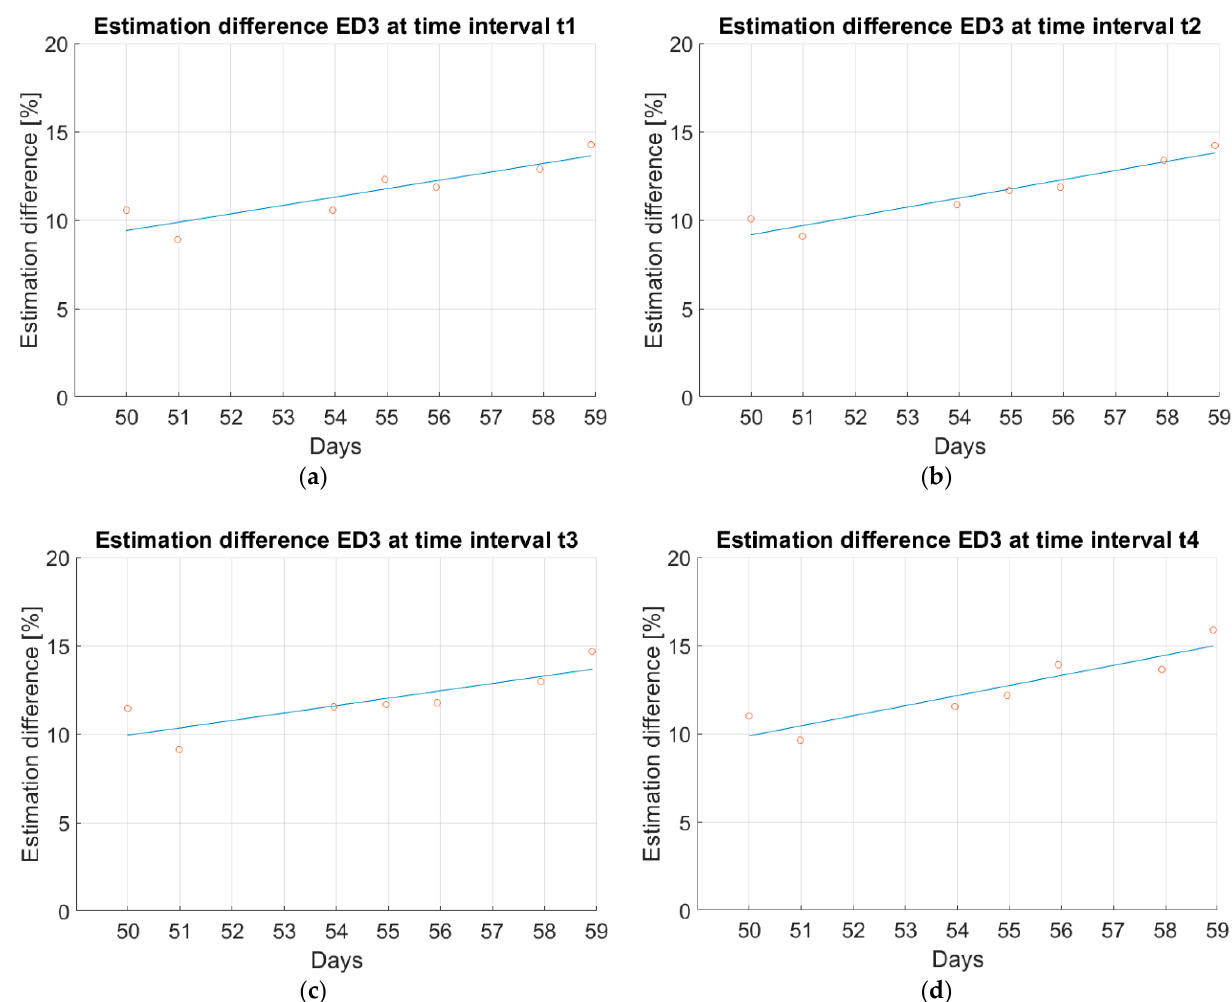
Figure 5. The linear regression analysis of estimation difference values for PV panel 3 for time intervals ( a ) t 1 , ( b ) t 2 , ( c ) t 3 , and ( d ) t 4.